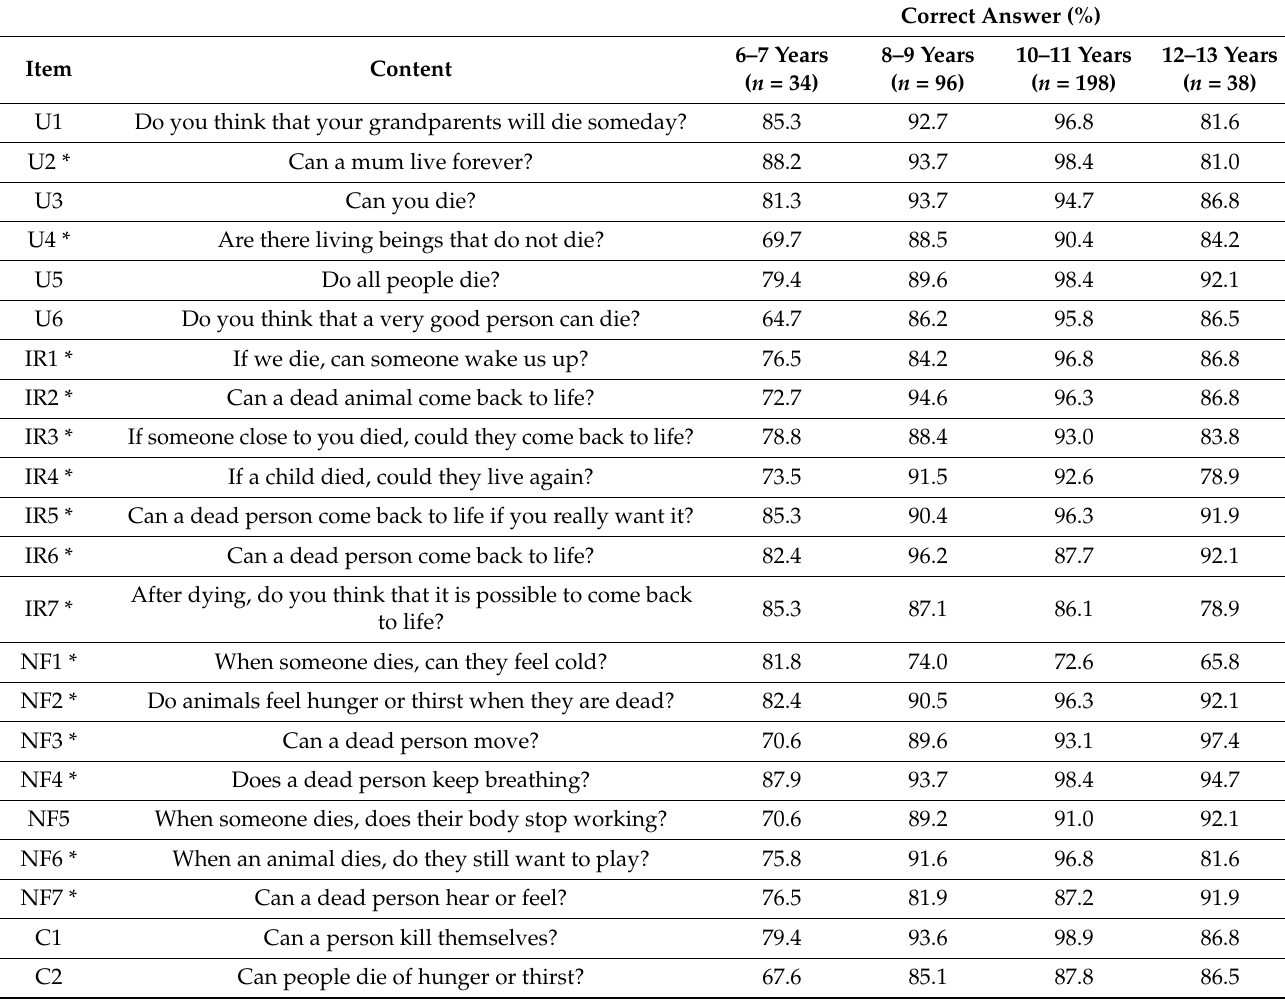
Table 3. Descriptive analysis of the EsCoMu scale items for each age